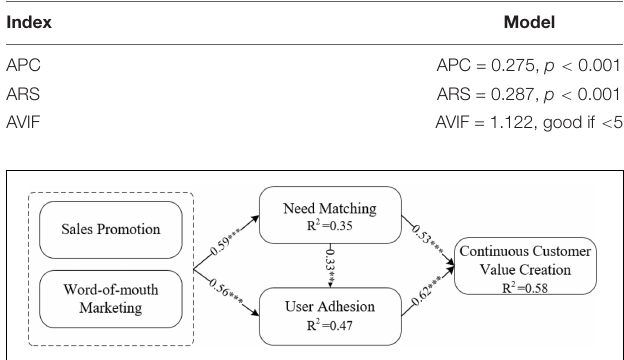
FIGURE 2 | Structural equation analysis results. * p < 0.05, ** p < 0.01, *** p < 0.001. *Represents the significant